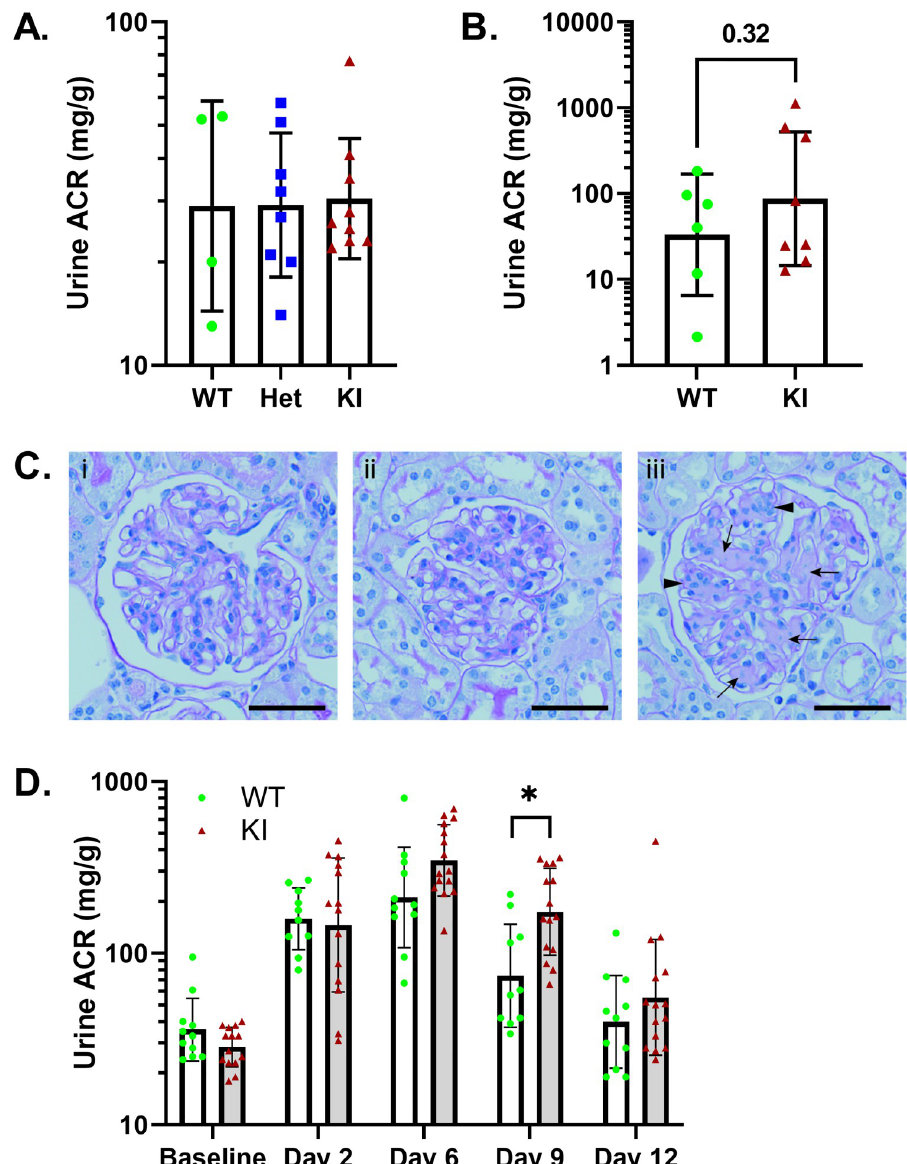
Fig 1. Baseline and albumin overload induced albuminuria in wild-type and Trpc6 E896K/E896K mice. A, urine albumin-to-creatinine ratio (ACR) measurements from six-month old, wild-type (WT), Trpc6 +/E896K (Het), and Trpc6 E896K/E896K (KI) males. Shown are individual values, geometric mean and SD; n = 4-9/group. Groups were compared by one-way ANOVA with Tukey’s multiple comparisons test; all comparisons without statistical significant differences. B, urine ACR from 20–23 month old, female WT (n = 6) and KI (n = 8) animals. Shown are geometric mean and individual values; log-transformed ACRs were compared by unpaired t-test. C, glomerular histology of 23 month old, female (i) wild-type, (ii) non-proteinuric KI, and (iii) albuminuric KI mice. Mesangial expansion (arrows) and mesangial hypercellularity (arrowheads) are apparent in the albuminuric animal. PAS stained sections; scale bar represents 20 μ m. D, albuminuria in WT and KI male mice subject to albumin overload from day 1–5. Shown are geometric mean, SD and individual values; n = 11 (WT) and 15 (KI). Log-transformed ACRs were compared between genotypes by mixed-effects analysis with Sidak’s multiple comparisons test. Trpc6 E896K/E896K had statistically significantly more albuminuria compared to wild-type only on day 9.